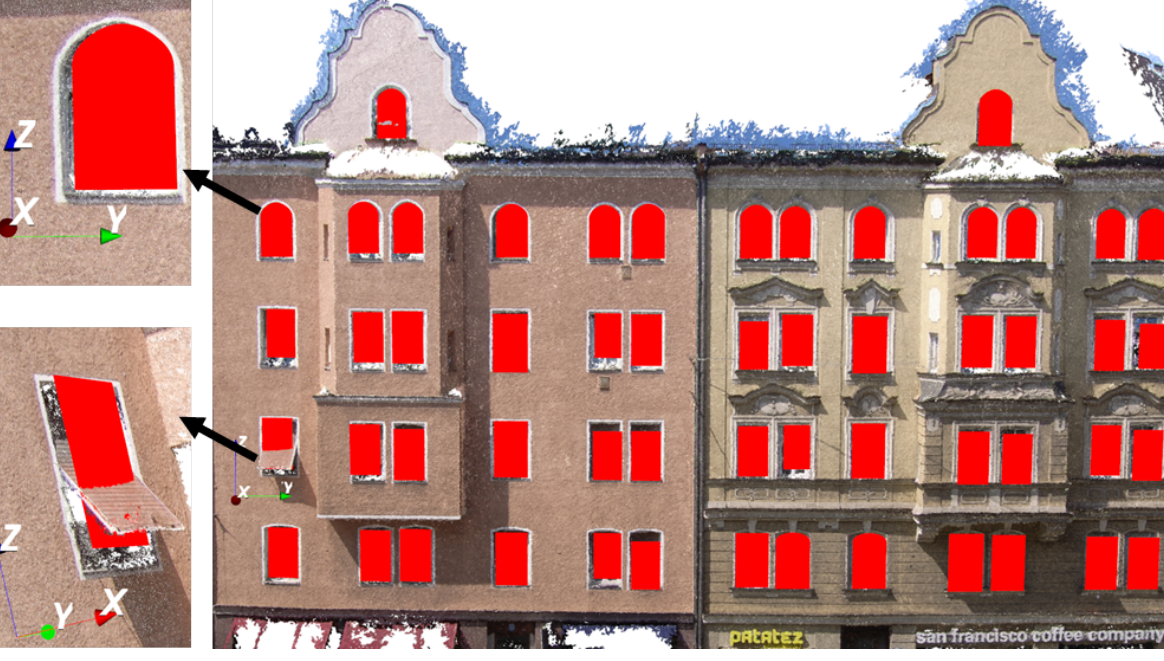
Figure 12: Filled red polygons representing localized windows and doors. Most often, segments of these outlines are embedded within the 3D point clouds of the facade. As mentioned in Figure 9, dimensions of windows and doors estimates may not be the same.